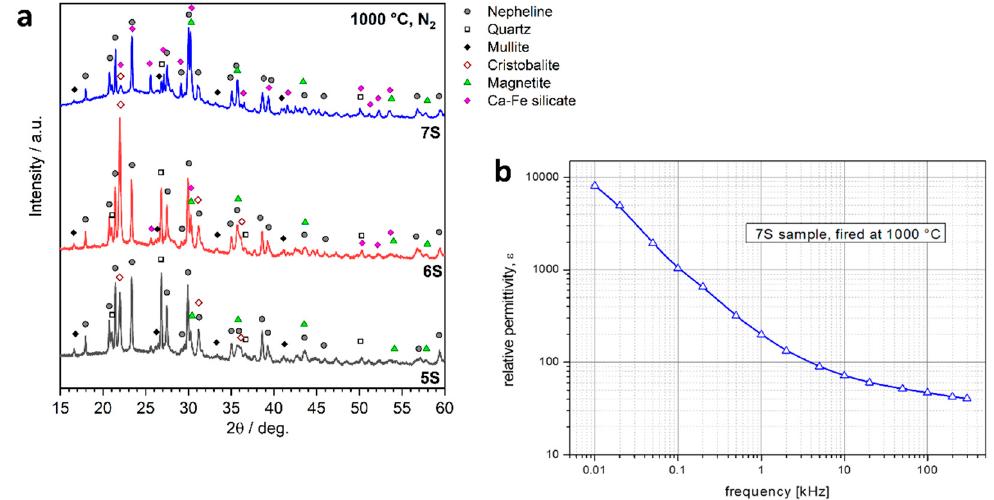
Figure 6. ( a ) Evolution of phase assemblage, after firing at 800 °C (in N 2 ) according to reduction of FA/glass ratio; ( b ) permittivity/frequency plot for 7S sample.